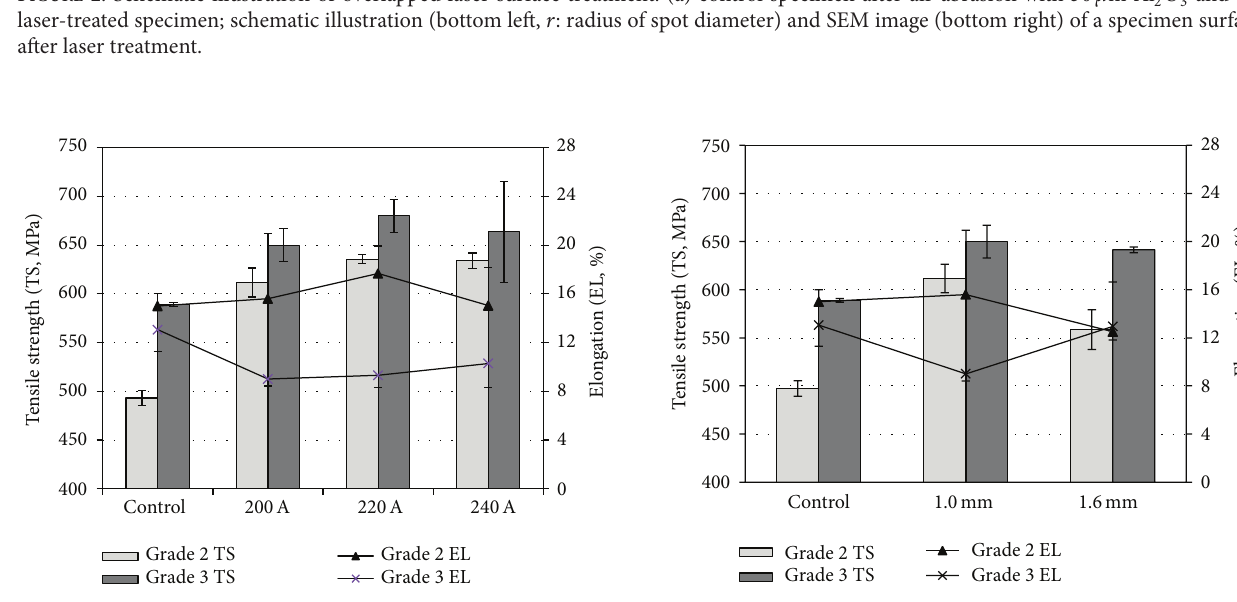
Figure 3: Tensile strengths and elongations of control specimens (grades 2 and 3) and the specimens laser-treated with several emission currents (200A, 220 A, and 240 A) at a constant pulse duration (10ms) and a spot diameter (1.0mm).